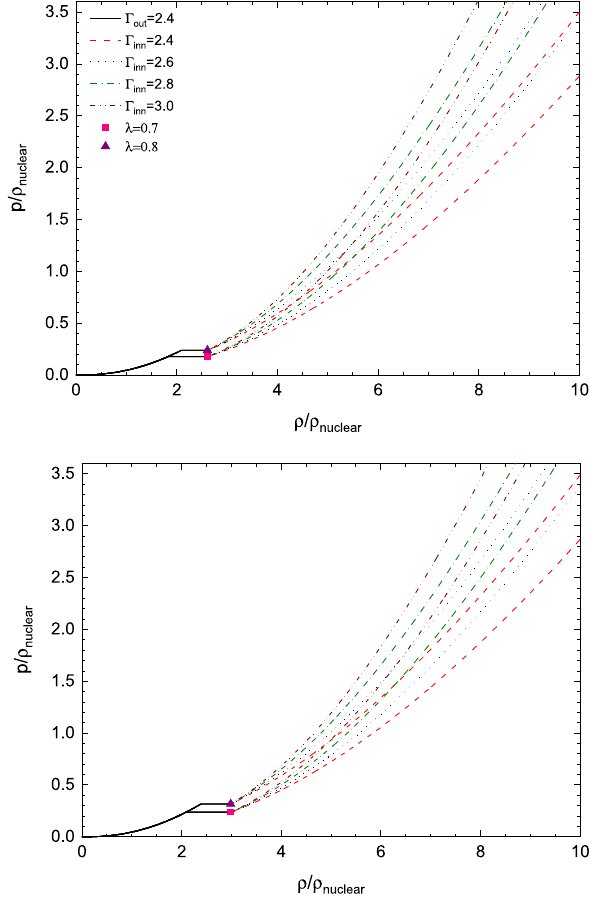
Fig. 1 Some equations of state for two density jump parameters λ . The fluid pressure p and energy density ρ are normalized by the nuclear density ρ nuclear = 2 . 68 × 10 17 [ kg / m 3 ] . On the top and bottom panel = 7 × 10 17 [ kg / m 3 ] and 8 × 10 17 [ kg / m 3 are respectively adopted ρ dis inn